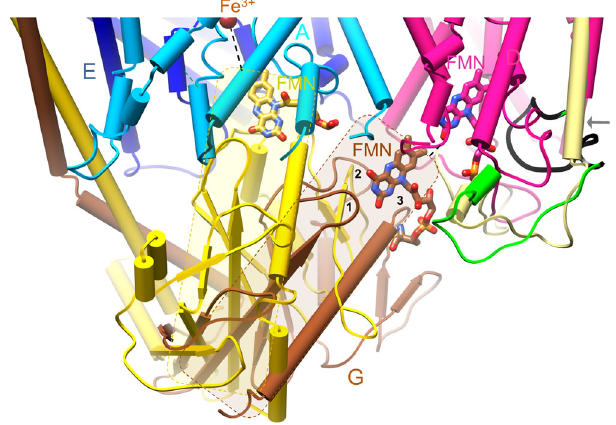
Fig. 5 | Superimposed RnfADEG and NqrEBDC core structures. RnfG (brown)/ NqrC (gold) are primarily built up of a β fold consisting of a central fi ve-stranded antiparallel β -sheet fl anked by one long N- and one C-terminal helix on both sides and some elongated linkers between β -strands. The extracellular RnfG is either attached to RnfD (hotpink) as in the cryo-EM structure or to RnfAE (NqrDE) as observed for NqrC in the Nqr crystal structure. Thus, FMN RnfG/NqrC is either in a productive ET distance to FMN RnfD or to the central Fe ion of RnfAE (NqrDE). Mobility of RnfG is rationalized by small respective contact areas. Different orien- tations between RnfG and NqrC are highlighted by transparent brown and gold rectangles. The exposed covalently attached FMN RnfG is fi xed by three protruding loops(markedby1,2,3);the fi rst(91 – 94)linkstwo β -strands,the second (114 – 128) a β -strandandasmallhelicalsegmentparalleltothe β -sheetandthethird(155 – 162) precedes the C-terminal helix. The orientation of RnfG substantially in fl uences the conformation of the fi ve-helix linker (green, yellow), in particular, the occlusion loop (black), which is transformed in Nqr to a prolonged helix 188:201 (VI) (gray arrow). The reason for the different orientations of RnfG and NqrC is unknown. Structural differences as e.g., the extracellular insertion 75 – 124 in NqrB and the deviating orientations of helix 21:42 (I) of RnfD have to be considered but also the high Na + concentration in the buffer (200mM NaCl) of Rnf and crystal- lographic effects of Nqr might play a role. Na + -dependent conformational changes are reported for NqrC 61 .